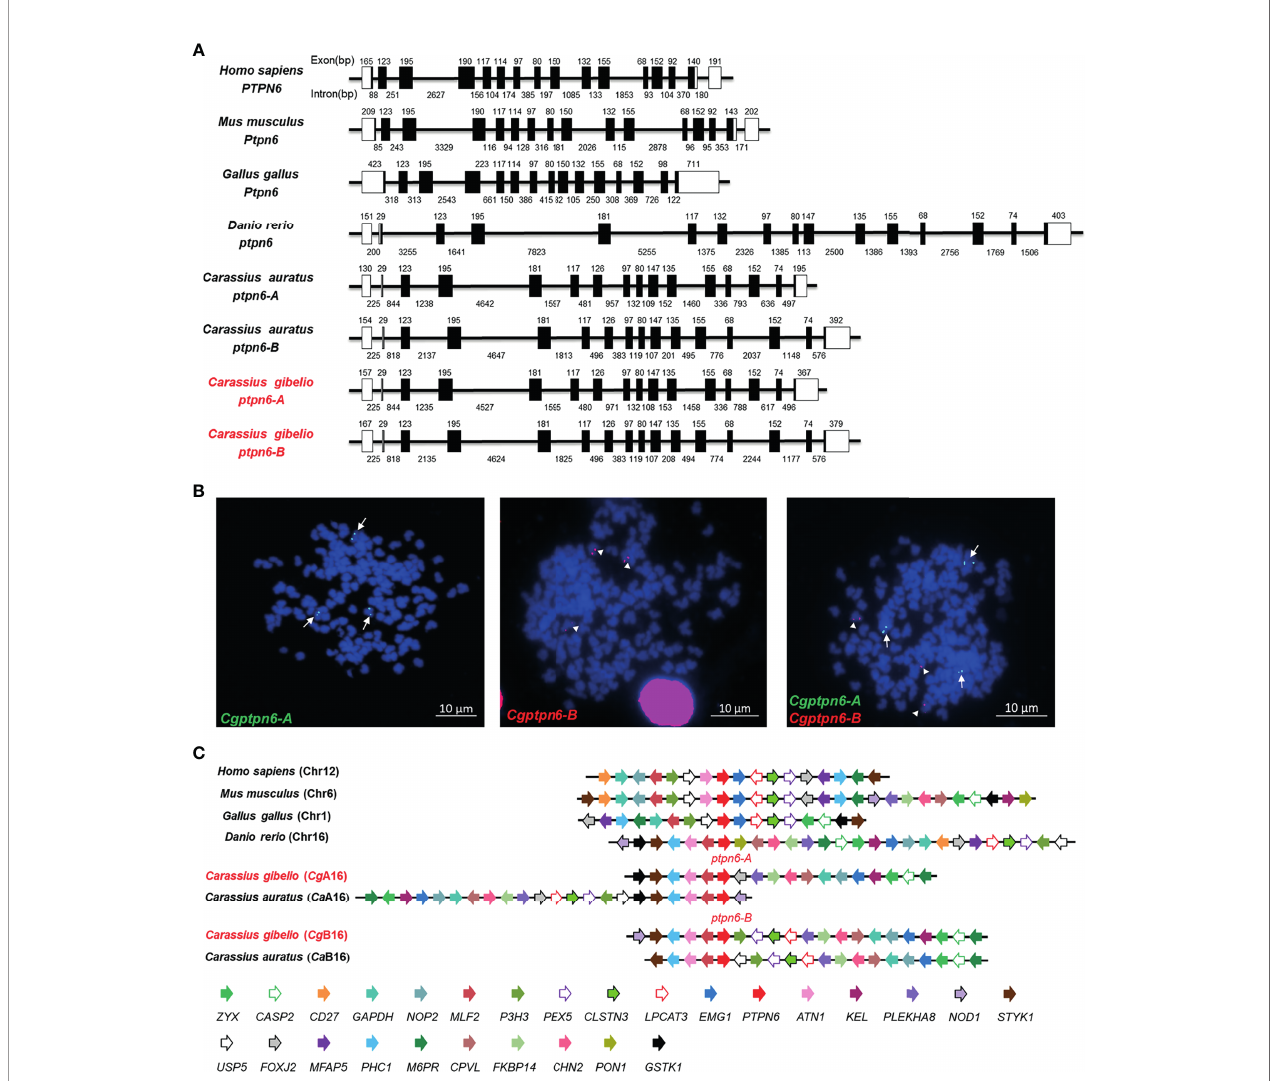
FIGURE 1 | Molecular characterization of Cgptpn6-A and Cgptpn6-B in gibel carp. (A) Genomic structure of ptpn6 genes. Exons and introns are shown by boxes and horizontal lines, respectively. ORFs are highlighted by black boxes. The exon and intron size are indicated upon or below themselves as base pairs (bp). (B) Localization of Cgptpn6-A (green, indicated by arrows) and Cgptpn6-B (red, indicated by arrowheads) on metaphase chromosomes (blue). Scale bars = 10 m m (C) Syntenic alignment of chromosomal regions around vertebrate ptpn6 genes. Cgptpn6-A and Cgptpn6-B are located on the chromosome Cg A16 and Cg B16 respectively. Chromosome segments are represented as thick lines. The conserved gene blocks are shown in matching colors and the transcription orientation are indicated by